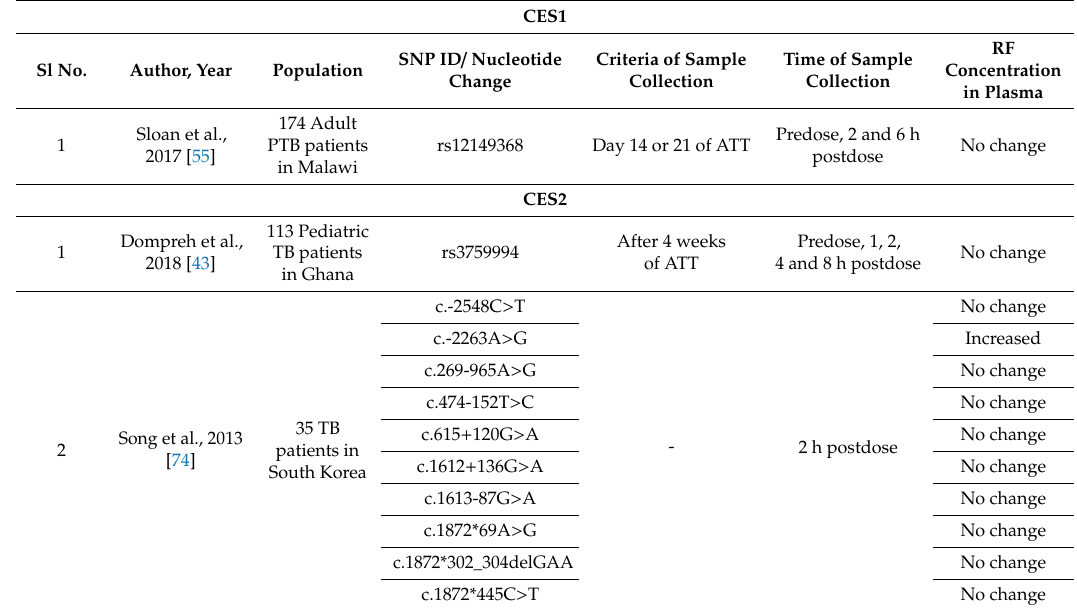
Table 5. Influence of CES1 and CES2 genetic variants on plasma RF levels.